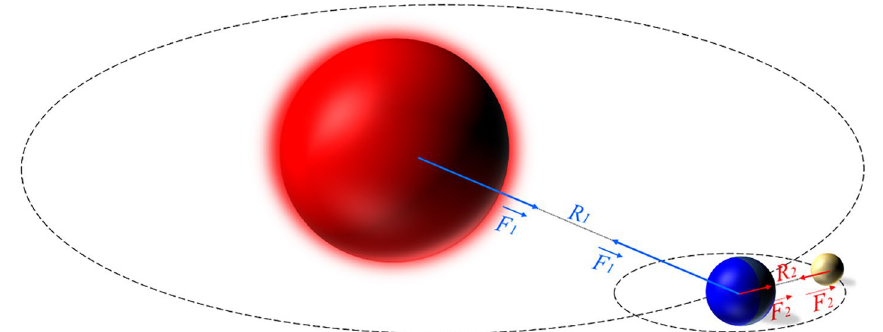
Figure 2. The gravitational force acting between